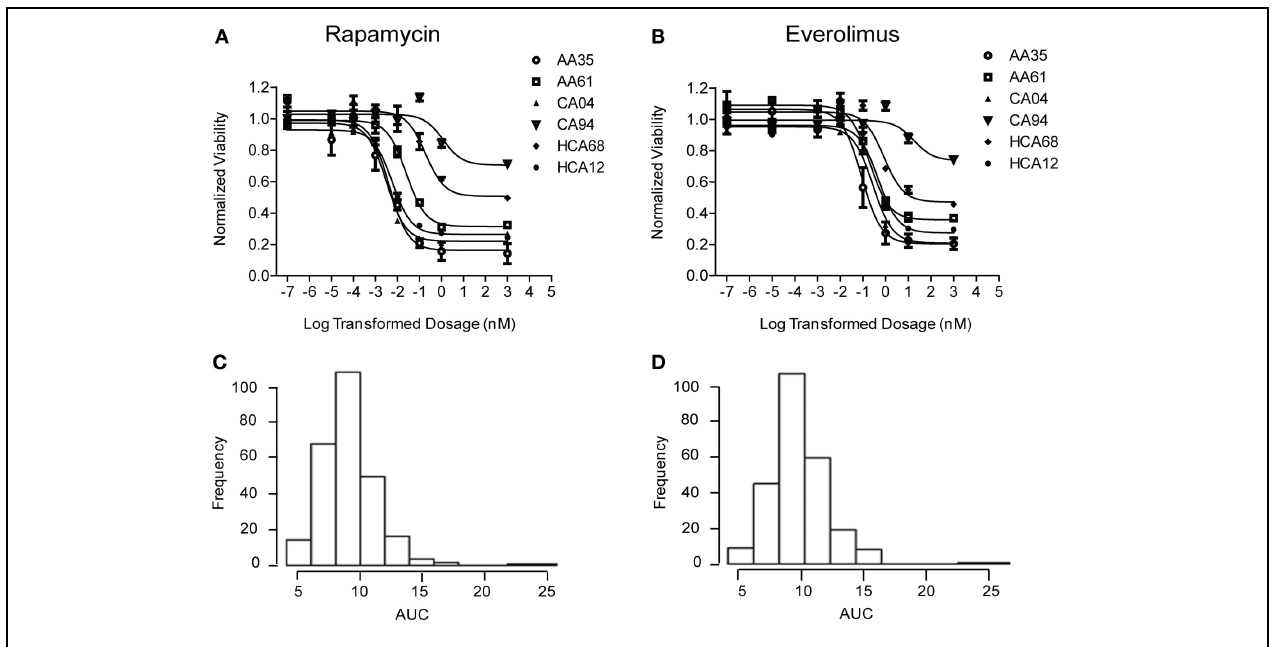
x-axis indicates the log transformed dosage (nM) and the y-axis indicates the cell viability normalized to control (without drug treatment). Symbols represent individual cell line from different ethnic groups. Histograms of frequency distributions of AUC values for Rapamycin (C) and Everolimus (D) for 272 lymphoblastoid cell